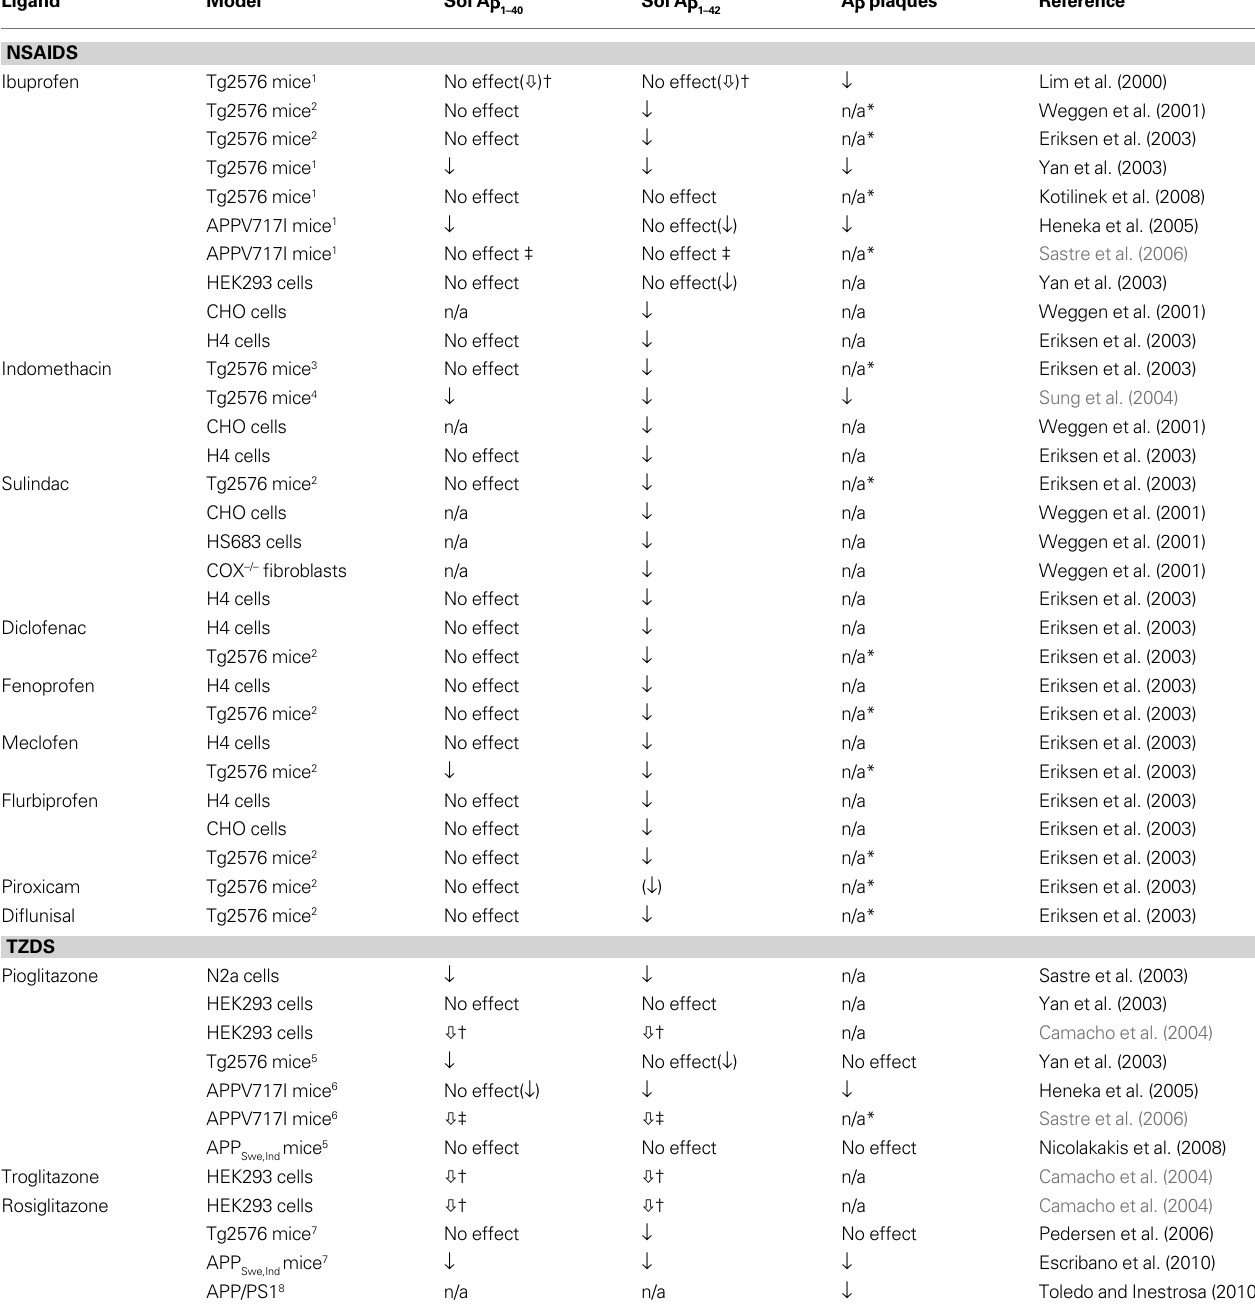
Table 1 Effects of PPAR γ ligands on amyloidosis in transgenic mice or APP-expressing cells